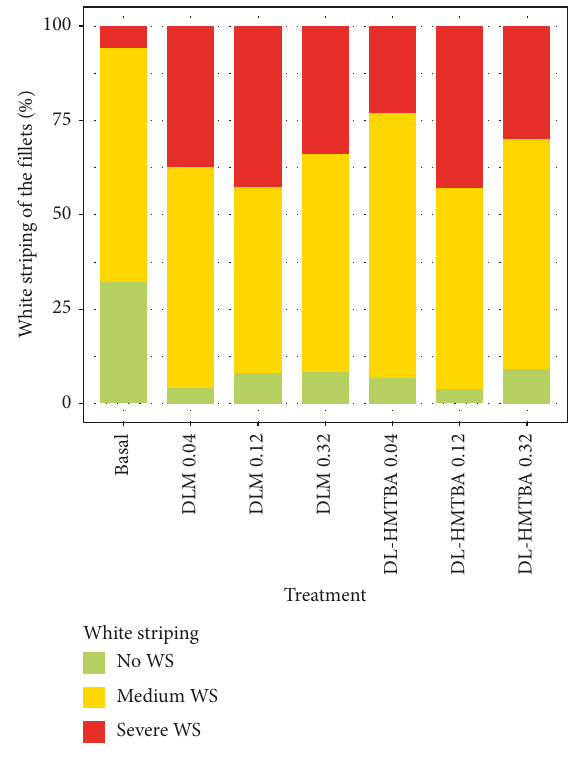
Figure 4: Occurrence of WS in breast